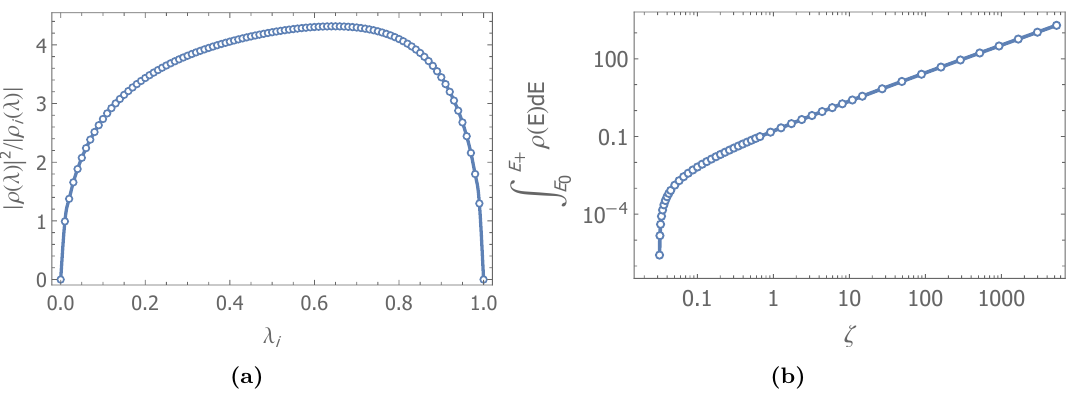
Figure 13. (a) The plot of density | ρ ( λ ( λ i )) | 2 / | ρ i ( λ ( λ i )) | along γ + as a function of λ i , the imaginary part of λ , with E i = 1 . (b) The amount of eigenvalues on γ + as a function of ζ . In both pictures, we set 2 φ b = 1 and e S 0 = 1